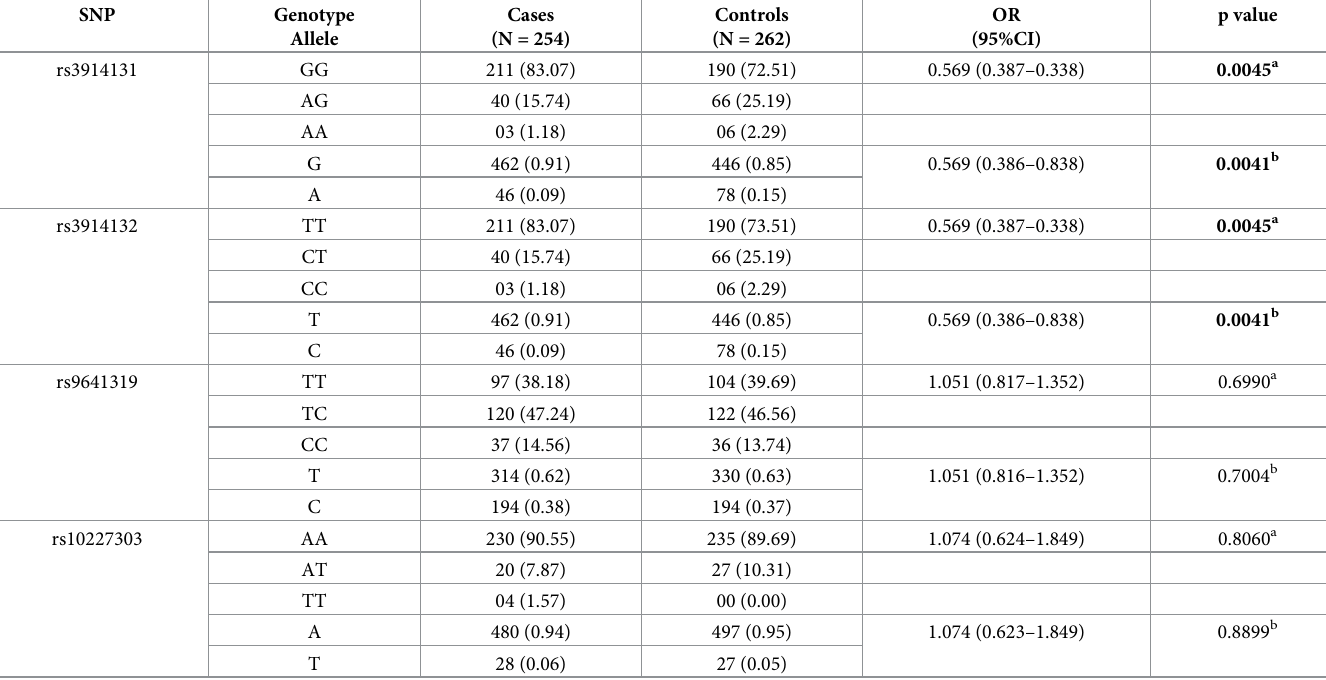
Table 1. Allele and Genotype frequencies distribution of RELN gene polymorphisms in non-syndromic otosclerosis cases and controls.